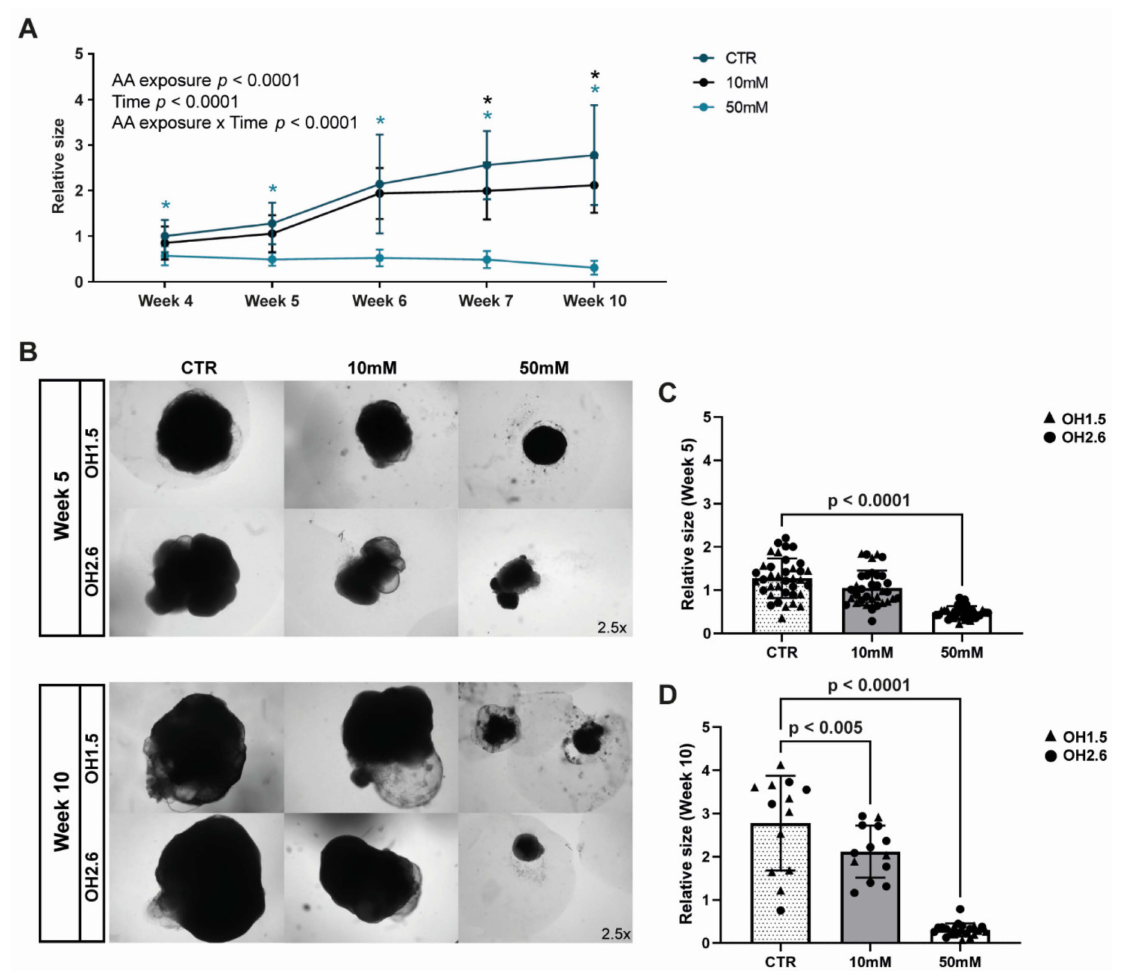
Figure 3. Growth responses to AA exposure in cerebral organoids. ( A ) Quantification of size measurements during 10 weeks of cerebral organoid development (mean ± SEM) for CTR, 10 mM AA-exposed, and 50 mM AA-exposed conditions. Data are expressed relative to the average of week 4 CTR cerebral organoid sizes within each cell line. N = 5–25 organoids per cell line (OH1.5 and OH2.6) per time point. Data were analyzed with a two-way ANOVA, from which p values are shown in the graph. Significant p values from post hoc Dunnett’s test for multiple comparisons are indicated by a blue asterisk for CTR versus 50 mM AA exposure (week 4–10 p < 0.0001) and a black asterisk for CTR versus 10 mM AA exposure (week 7 p = 0.0041; week 10 p = 0.0008), * p < 0.005. ( B ) Representative bright-field microscopy images (2.x magnification) of cerebral organoids at week 5 and week 10 of differentiation from 2 different cell lines (OH1.5 and OH2.6) for the different AA-exposed conditions (10 mM and 50 mM AA exposure and control). ( C , D ) Quantification of size measurements at week 5 ( C ) and week 10 ( D ) of cerebral organoid differentiation for CTR, 10 mM AA-exposed, and 50 mM AA-exposed conditions. Data are expressed relative to the average of week 4 CTR cerebral organoid sizes within each cell line. Bar graphs show mean ± SEM and individual data points (circles = OH2.6; triangles =